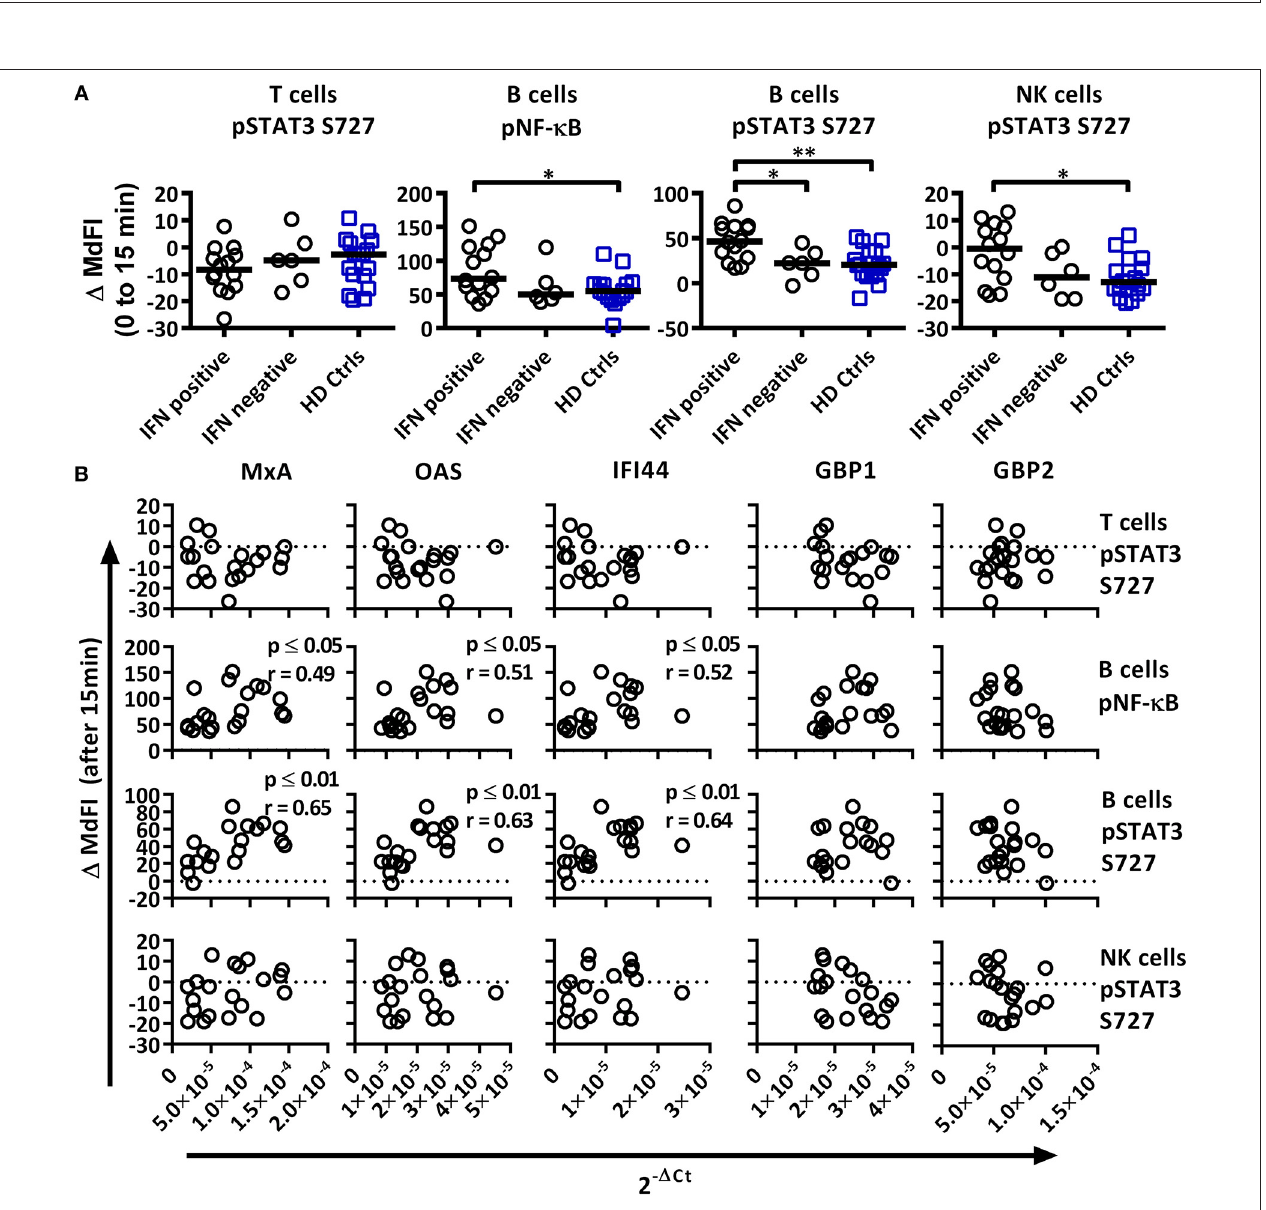
FIGURE 5 | Associations of the phosphorylation profile 15min after TLR7 and − 9 stimulation with IFN inducible gene expression in pSS patients and healthy controls. (A) Unpaired Mann-Whitney test comparisons of phosphorylation levels after TLR7 and − 9 stimulation for IFN signature positive patients ( n = 14), IFN signature negative patients ( n = 6) and healthy controls ( n = 17), medians are given by black bars. (B) Correlation plots of variable identified by PCA and three type I IFN inducible genes ( MxA , OAS1 , IFI44 ) and two type II IFN inducible gene ( GBP1 , GBP2 ) for pSS patients ( n = 20). Correlations were assessed with Spearman’s rank test, with outliers removed using robust regression and outlier removal (ROUT) method and a ROUT coefficient Q of 1 was used. Significant values are indicated as * ≤ 0.05 and ** ≤ 0.01. The flow cytometric data represents 17 healthy controls and 20 patients pooled from 13 independent experiments, with real time qPCR data representing a single experiment incorporating the 17 healthy controls and 20